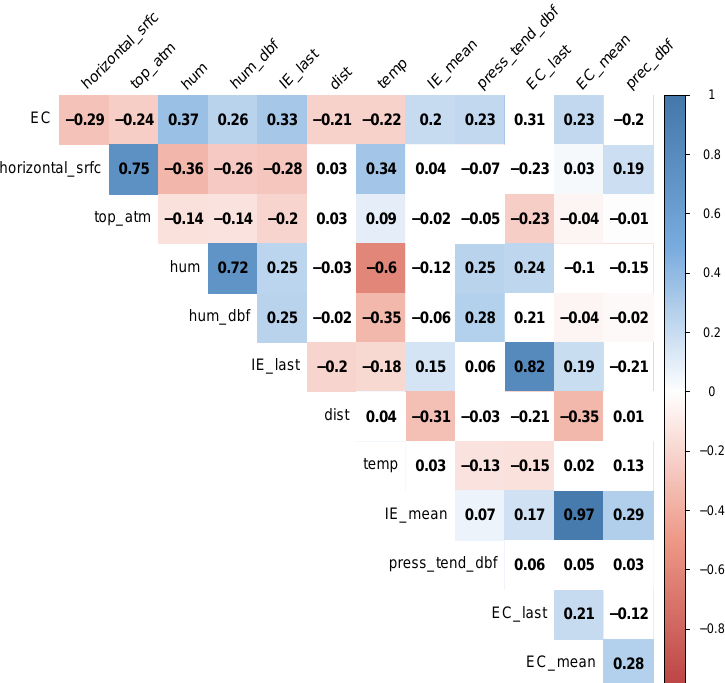
Figure 8. Correlation plot of parameters with strongest correlation with E. coli . Description of features is given in Table 2.